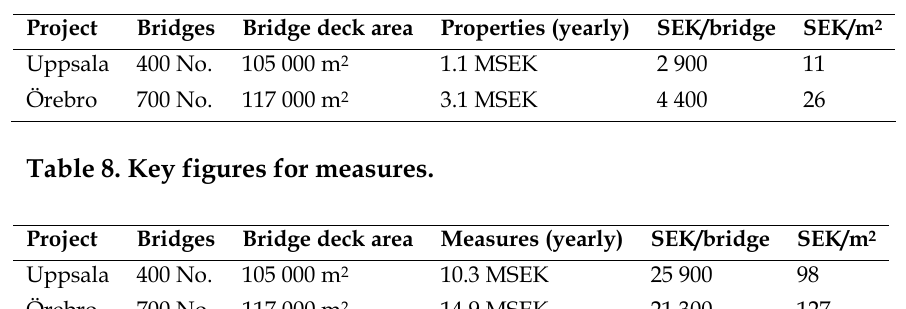
Table 7. Key figures for properties.